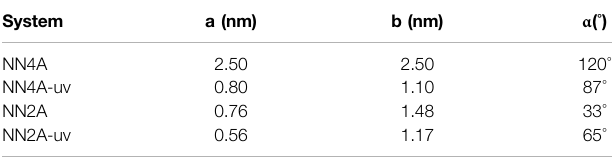
TABLE 1 | Experimental (Expt.) and calculated (Cal.) cell parameters of NN4A and NN2AbeforeandafterlightirradiationontheHOPGsurface.Themeasurement error for the length is 0.1 nm, and that of the angle is 1 °